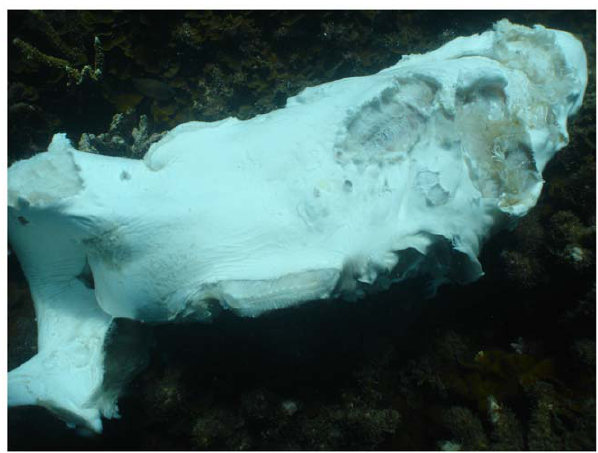
Figure 1. A finned reef shark in the Great Barrier Reef World Heritage Area. This carcass was one of several found illegally dumped at Wreck Beach on Great Keppel Island (Photo taken by R. Berkelmans on 17 November 2006).